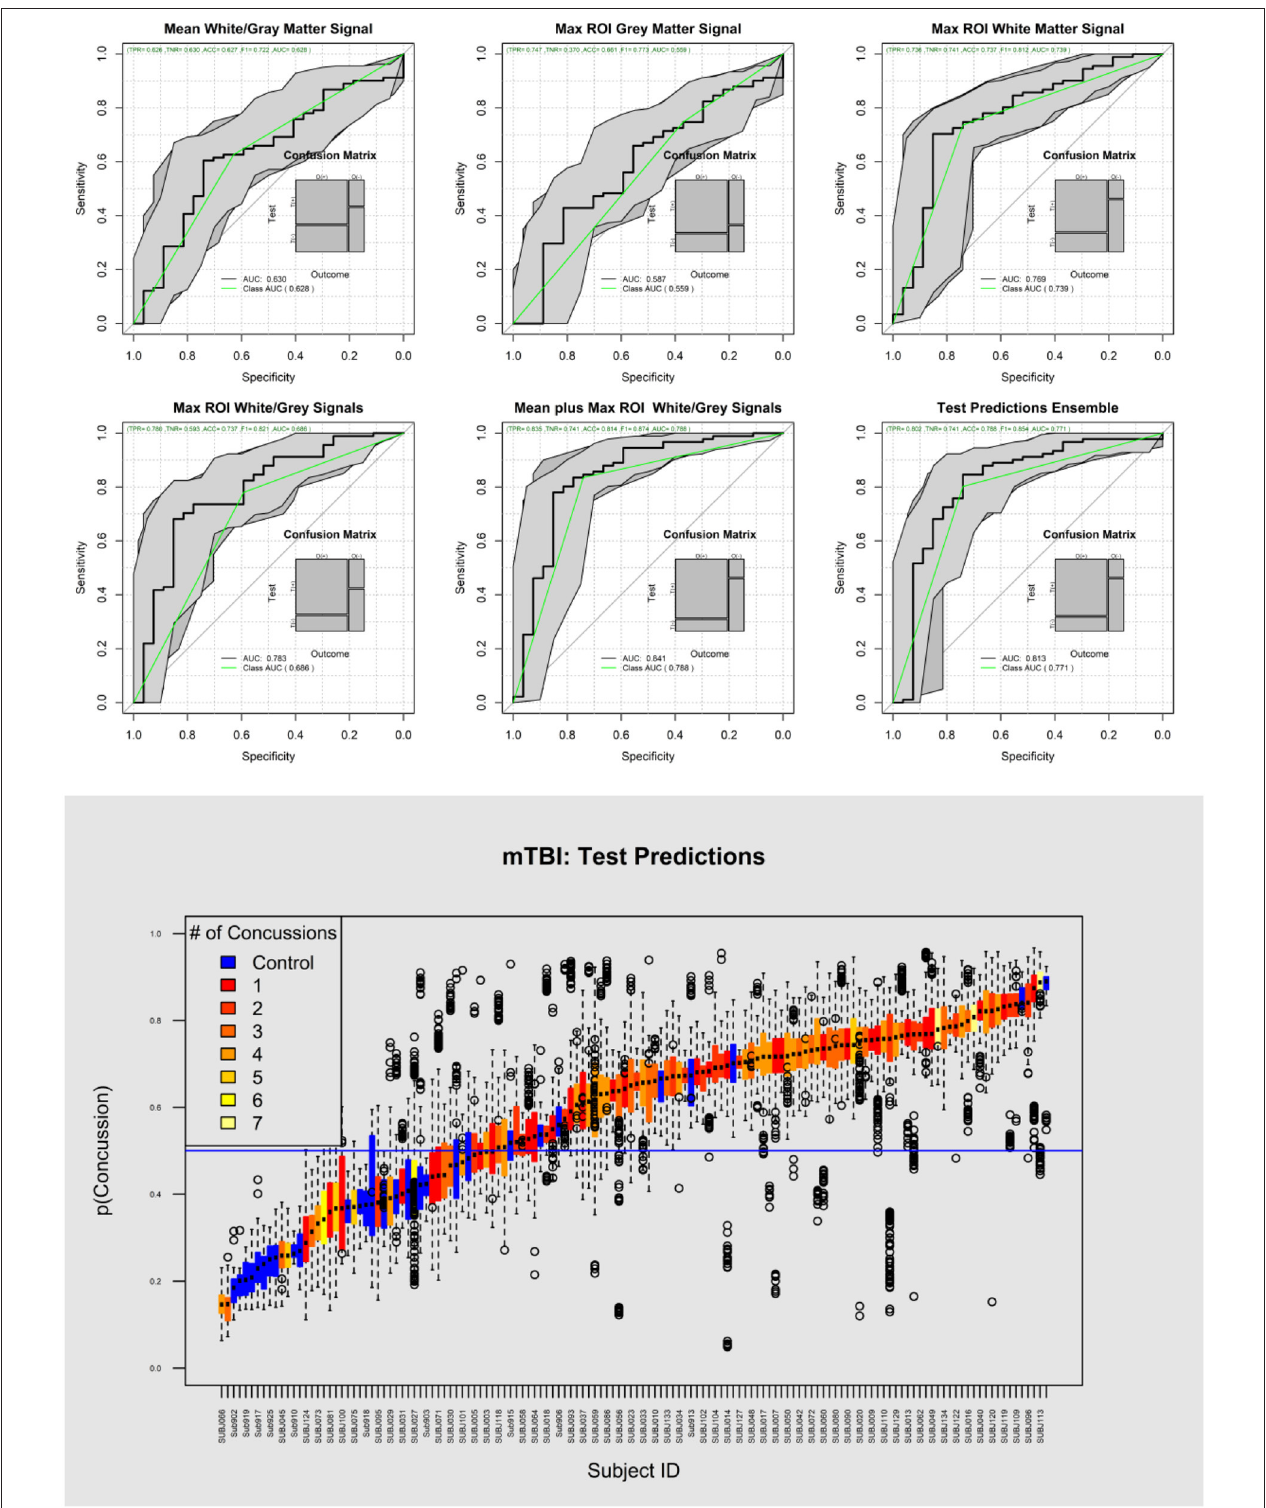
FIGURE 4 | Top, ROC curves of the five different sets of analyzed data plus the average prediction performance (Ensemble prediction of the top four sets). The model based on only gray matter features poorly predicted PCS (AUC = 0.59). On the other hand, the white matter model showed superior performance (AUC = 0.77). Bottom, the probability of detecting the presence of concussion for each subject and each one of 1,000 test results are represented as box plots.